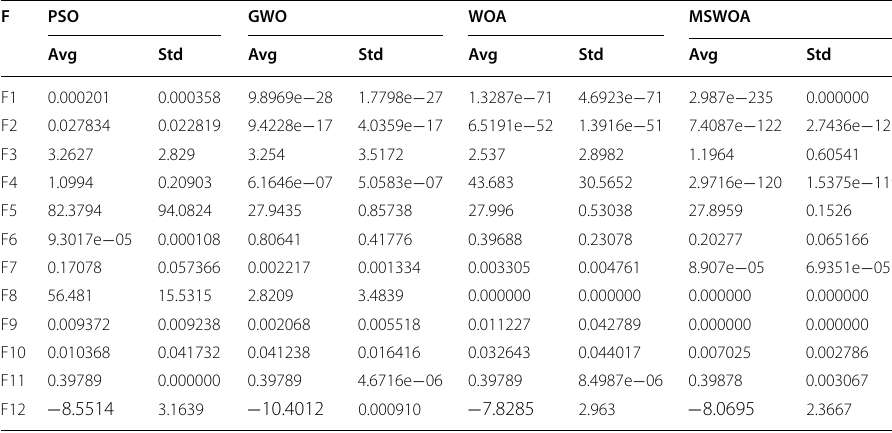
Table 3 Performance comparison of four